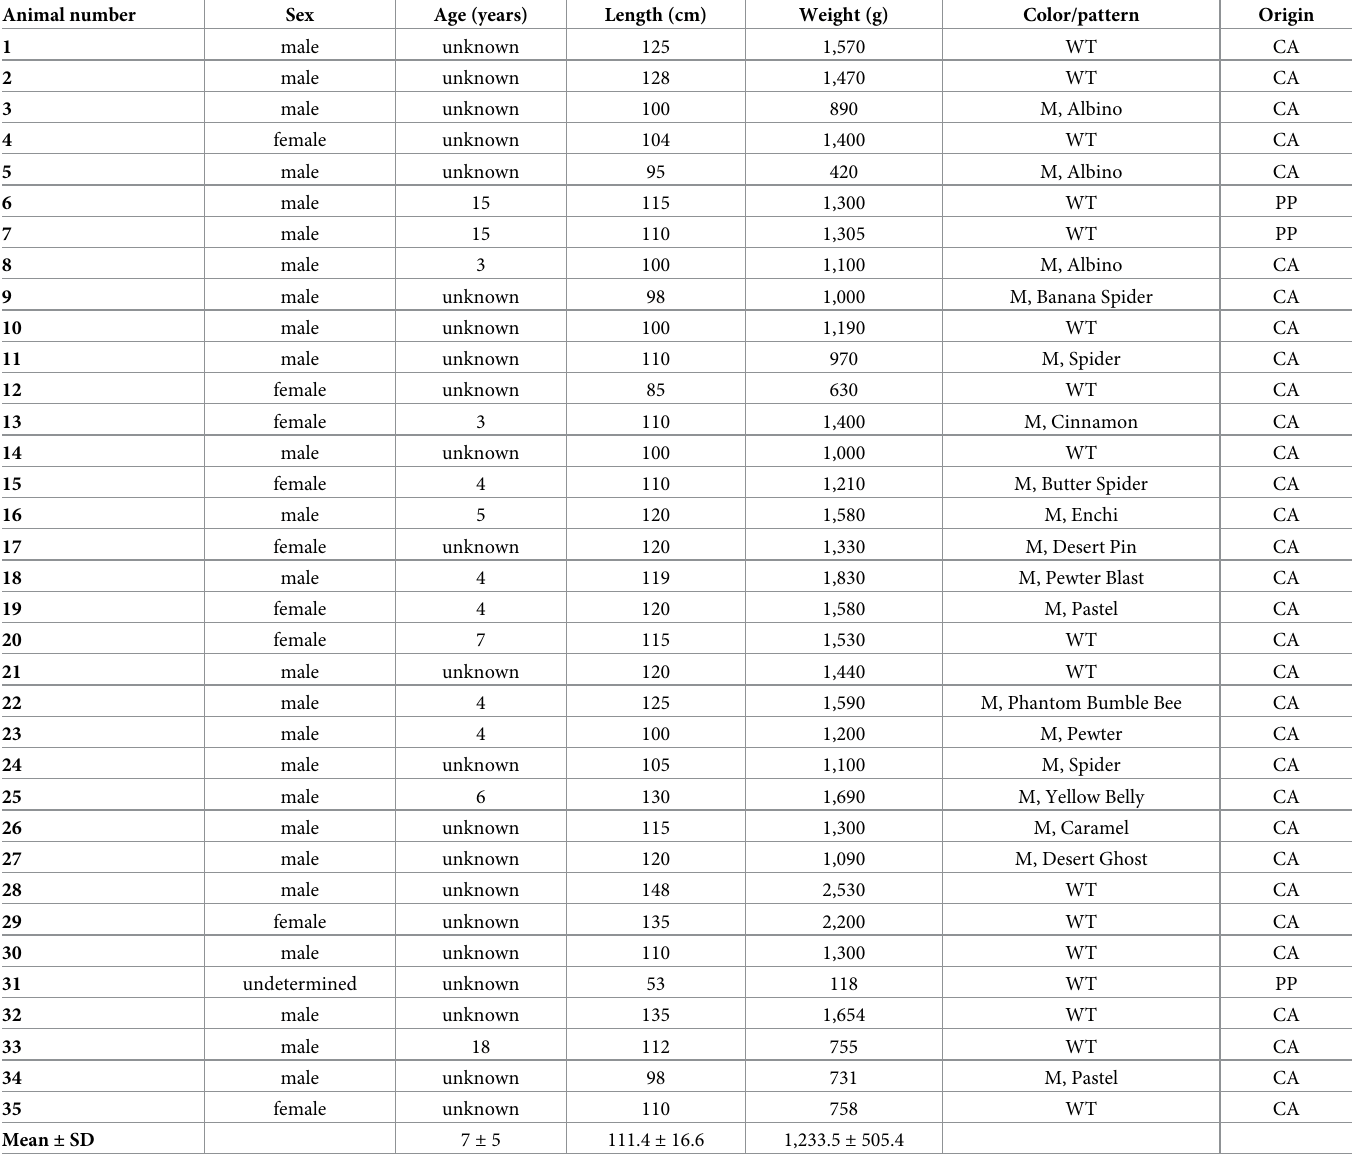
Table 1. Characteristics of the studied ball pythons ( n =